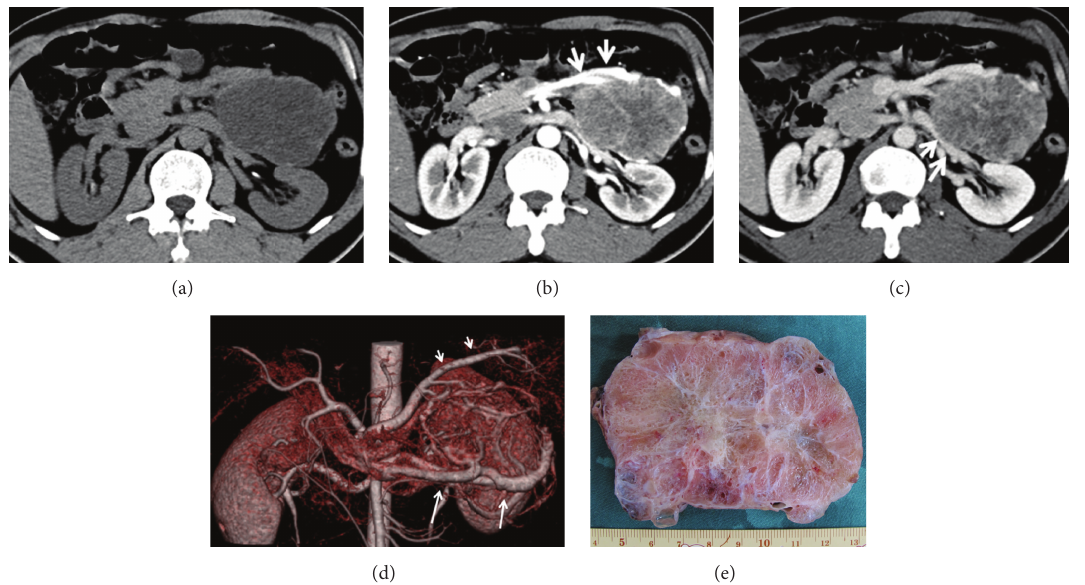
Figure 1: A 48-year-old male patient with a giant serous cystadenoma of the pancreas. (a) A low-density pancreatic tumor was noted on CT plain scan. (b) The tumor showed early enhancement with abundant draining vein (arrow) on arterial phase image. (c) The tumor showed honeycomb-like shapes with decreased enhancement on portal phase image. Left renal vein compression was noted (arrow). (d) The feeding splenic artery (short arrow) and draining veins (long arrow) were showed on CT angiography (CTA). (e) The tumor specimen was honeycomb-like appearance with central scars.